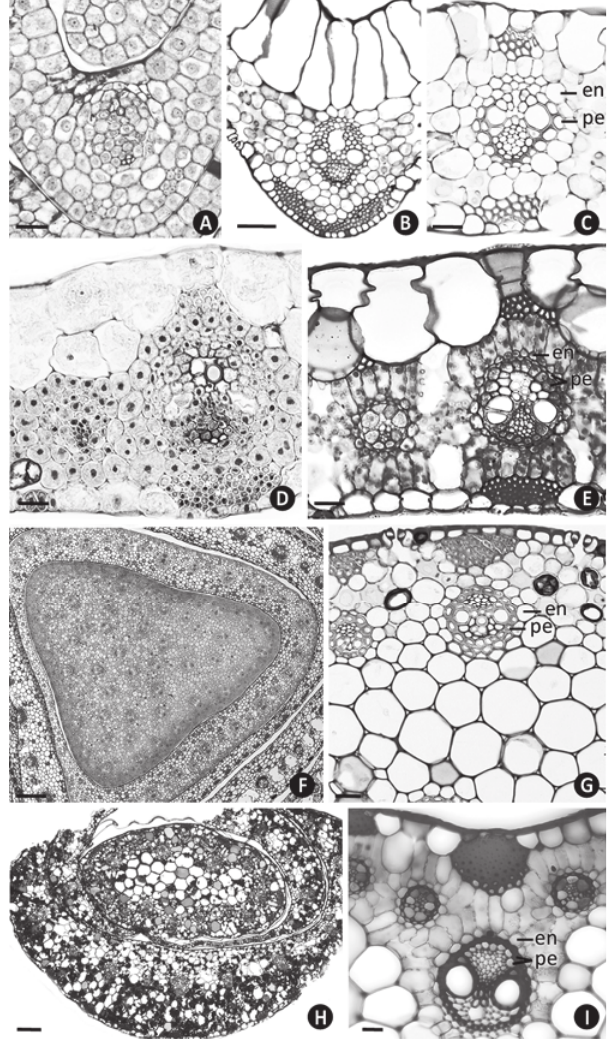
Fig. 3 - Anatomical aspects of transverse sections of leaves and scapes of Cyperaceae species: Cyperus laxus L. and Fimbristylis dichotoma Vahl. A-C. Cyperus laxus . A. Detail of the young leaf in the midrib region; B-C. Detail of the mature leaf; B. Midrib; C. Mesophyll; D-E. Fimbristylis dichotoma; D. Young leaf; E. Mature leaf; F-G. Cyperus laxus ; F. General view of the young scape; G. Detail of the mature scape; H-I. Fimbristylis dichotoma ; H. General view of the young scape; I. Detail of the mature scape. en = endodermis; pe = pericycle. Bars: 100 µm (F); 50 µm ( A, B, C, H ); 20 µm ( D, E, G, I